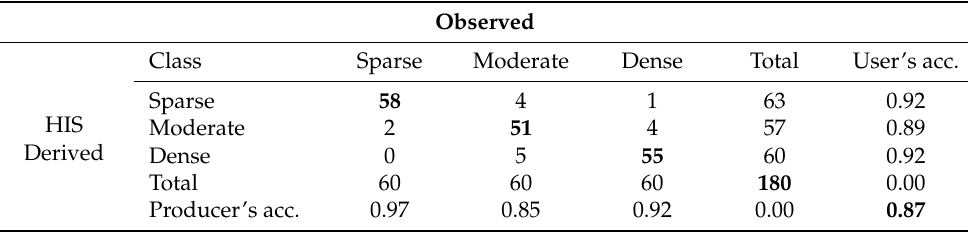
Table 4. Confusion matrix of vegetation classes derived from hyperspectral imagery.